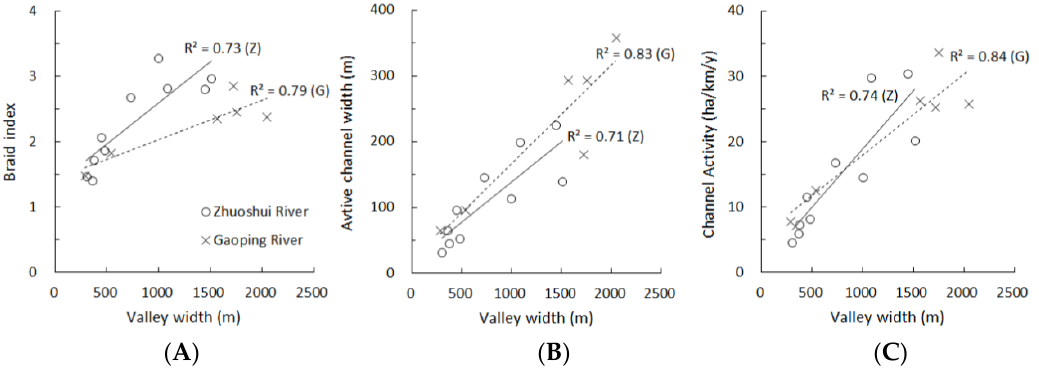
Figure 7. The x-y plots for relationships between valley width and braid index ( A ); active channel width ( B ); and channel activity ( C ) in the study reaches.